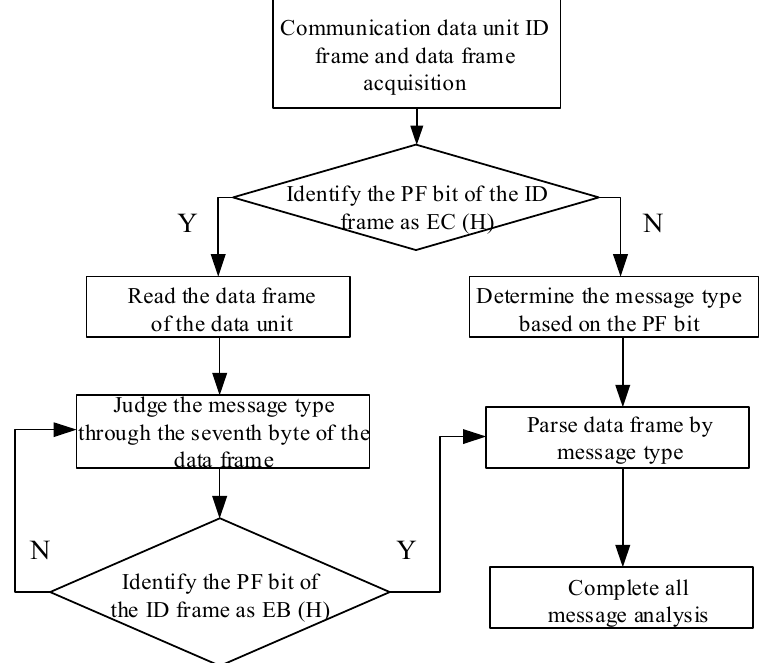
Figure 9. Message analysis program flow chart.